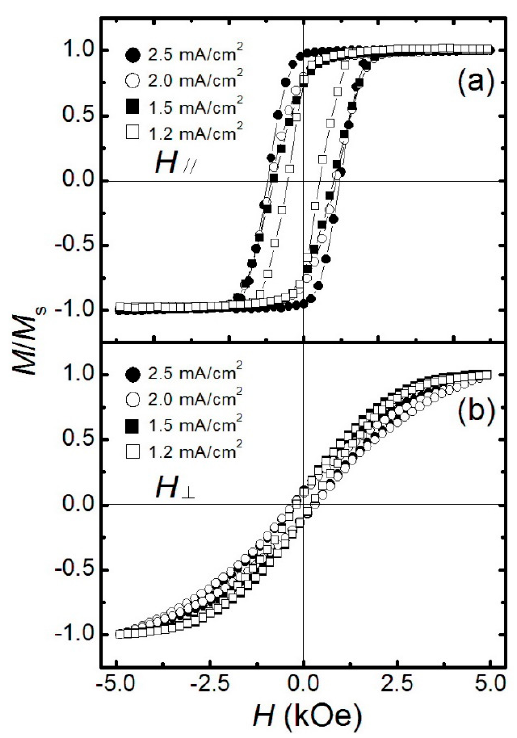
Figure 4. The magnetization hysteresis loops of the samples with the magnetic field applied ( a ) parallel ( H // ) and ( b ) perpendicular ( H ⊥ ) to the axis direction of the nanowire arrays prepared at various current densities (1.2 mA/cm 2 ~2.5 mA/cm 2 ).